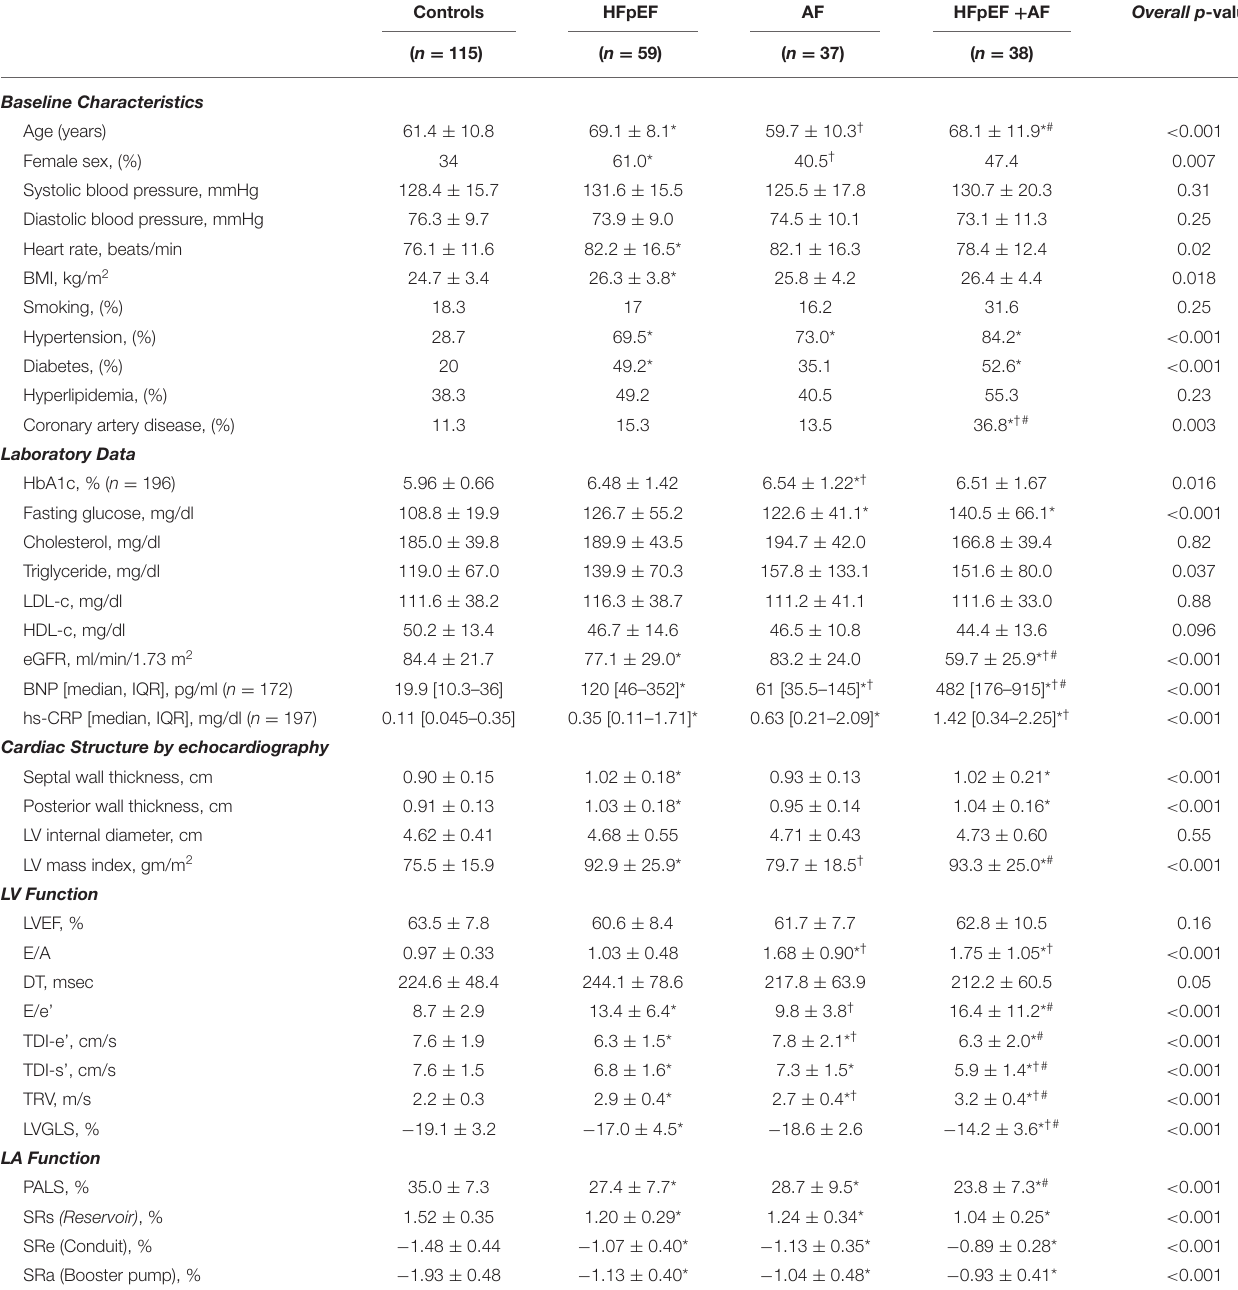
TABLE 1 | Baseline characteristics and conventional echocardiographic parameters of the study subjects.